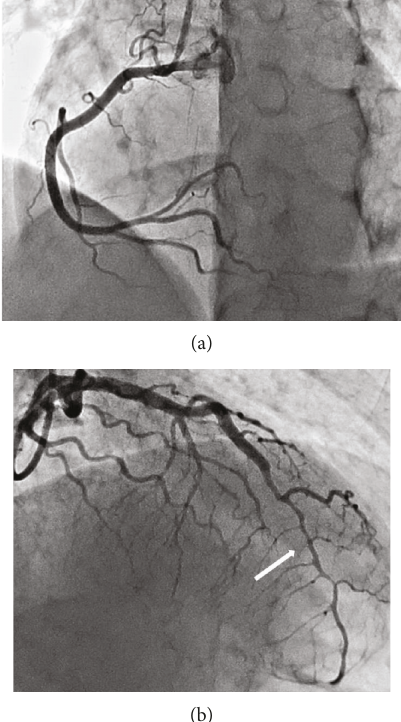
Figure 3: Coronary angiography view 4 days after admission with dissection of the